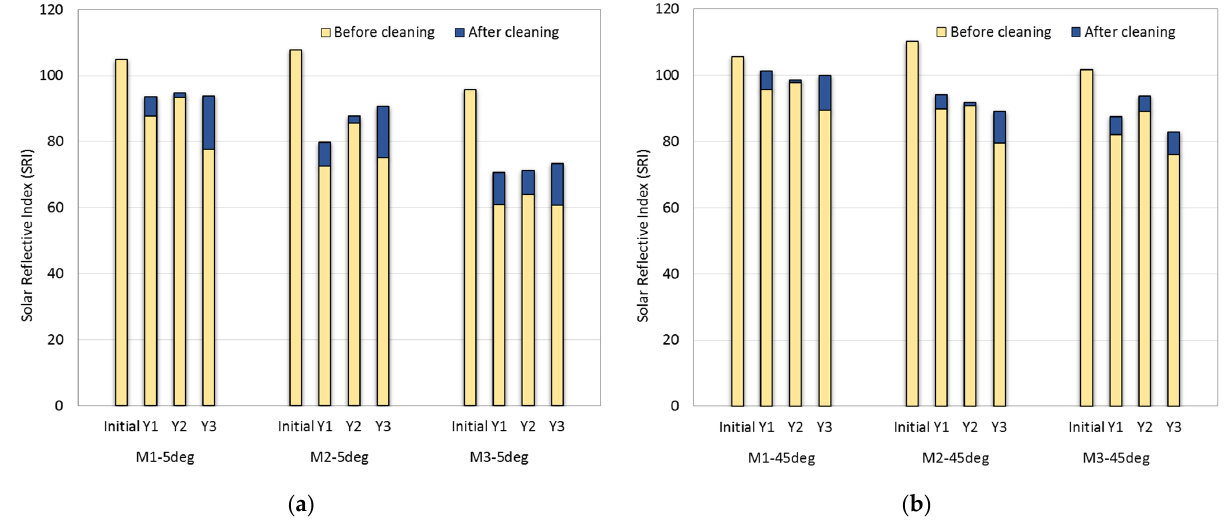
Figure 10. Effect of cleaning on solar reflective index: ( a ) 5° tilt and ( b ) 45° tilt.